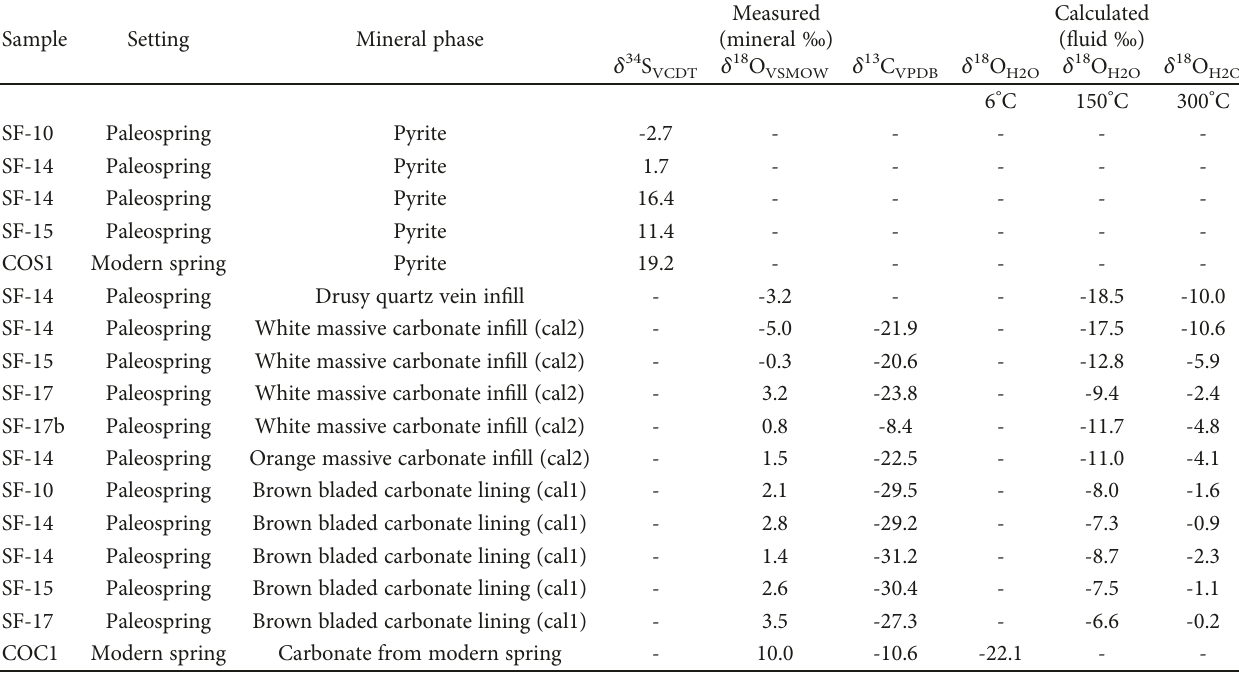
Table 5: Stable S-O-C analyses of mineral separates from modern spring/paleospring, and 1 calculated water δ 18 O. Sample